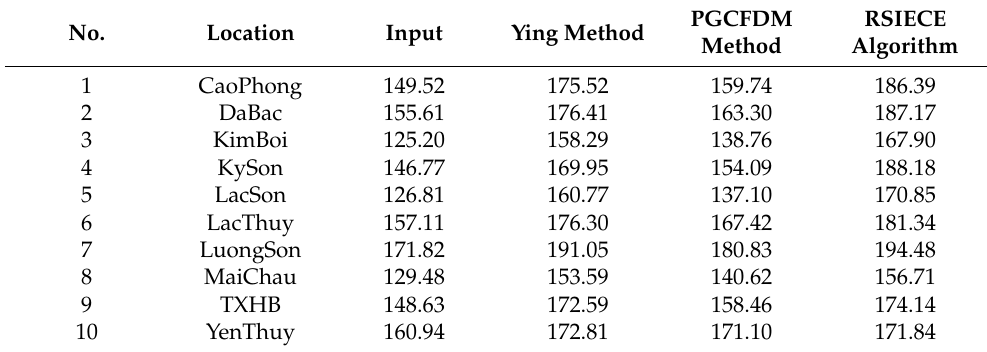
Table 2. Mean index of enhanced images by the RSIECE algorithm compared to the Ying and PGCFDM methods.